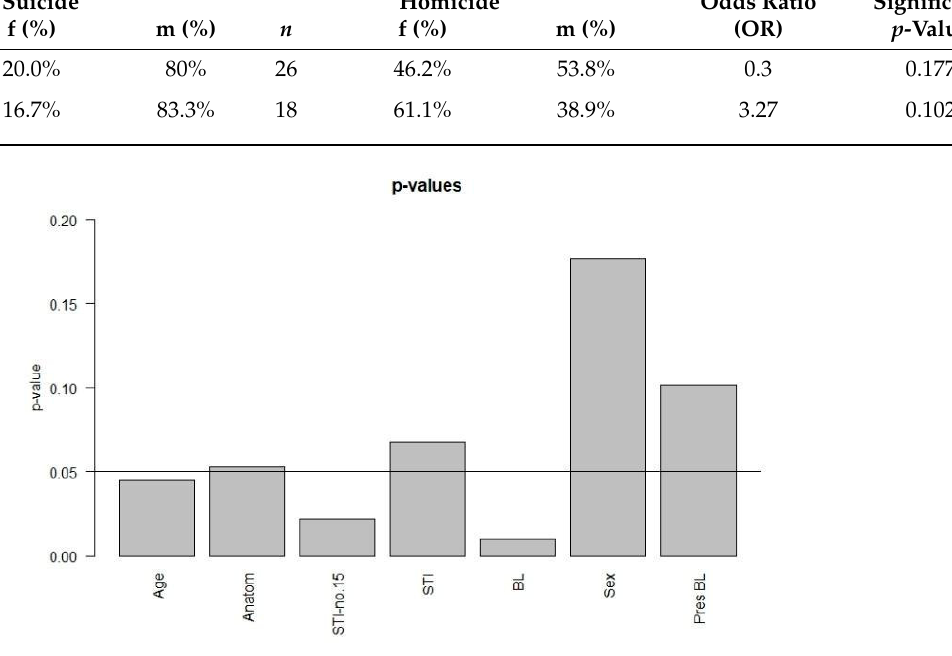
Table 8. Eta ( η ) 2 - and p -values of Mann-Whitney-U tests.